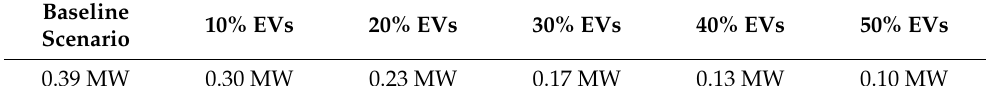
Table 4. Active power losses in the HEDNO distribution network for the different scenarios considered. Baseline